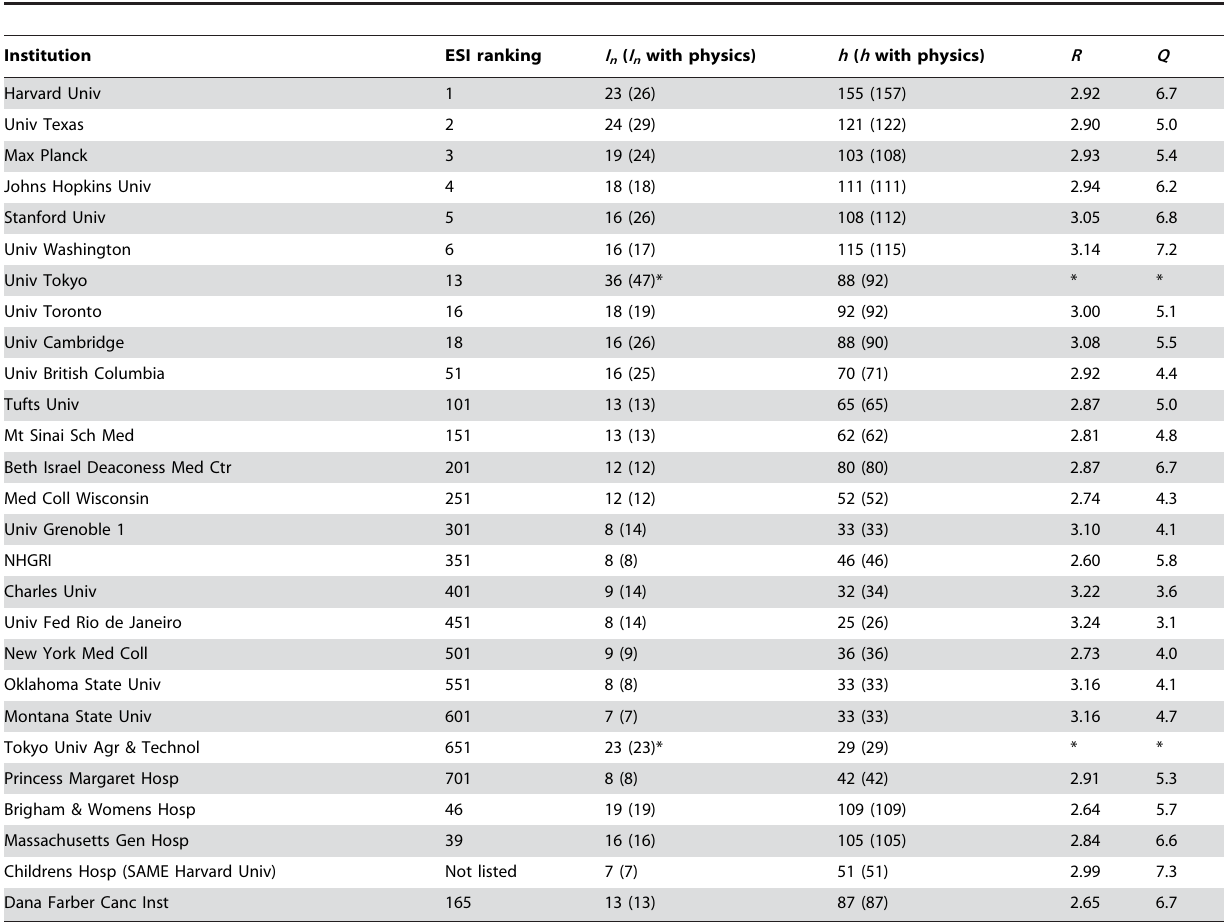
Table 1. Networking size and citation impact for various